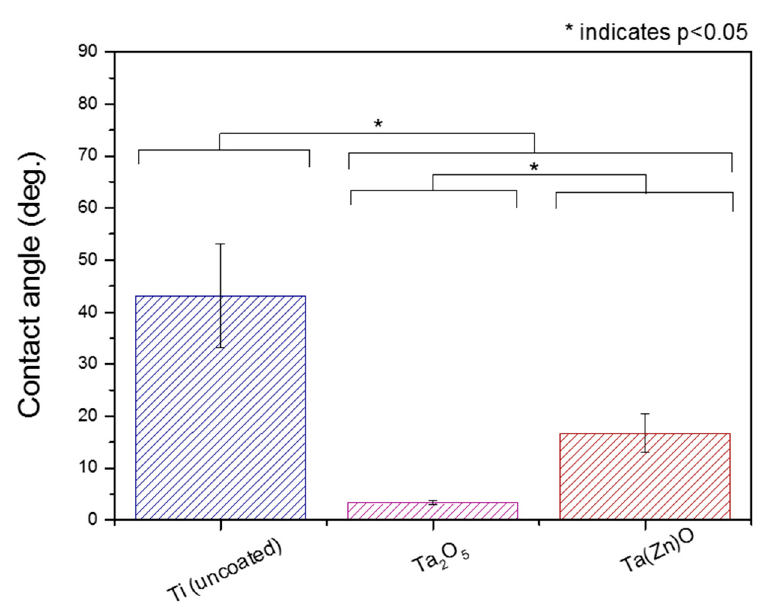
Figure 3. Contact angles of the uncoated Ti, and Ta 2 O 5 and TaZnO coated titanium samples. The mean vales of contact angles were different significantly among the untreated Ti, and Ta 2 O 5 and Ta(Zn)O coated titanium samples ( p < 0.05). Post-hoc pairwise comparisons were conducted by the Turkey test. The differences were considered significant when p < 0.05.